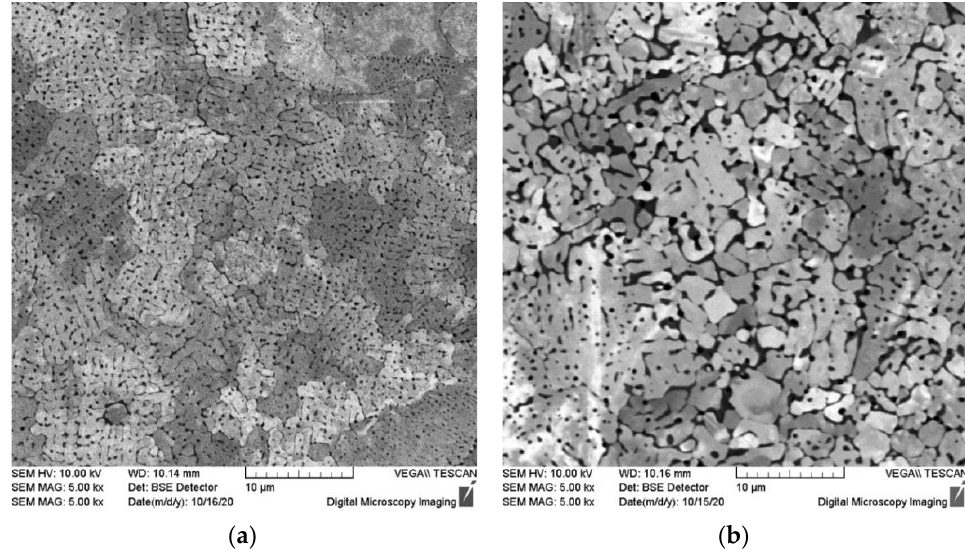
Figure 13. Images of the W-5Ni-2Fe SLM samples structure produced at different laser power of 600 W ( a ) and 900 W ( b ) under laser scanning velocity of 500 mm/s.